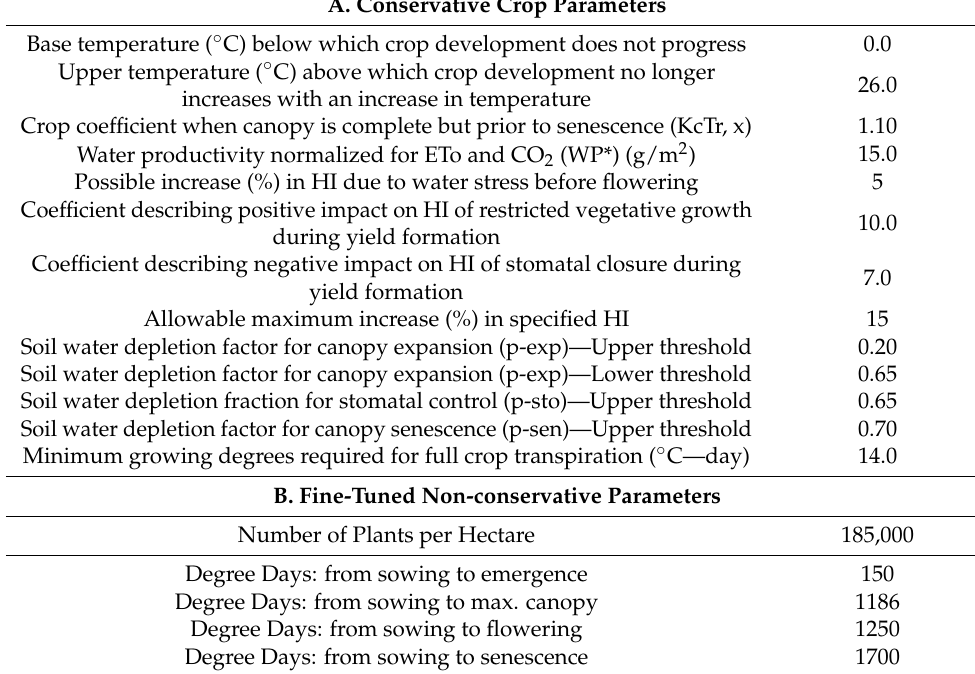
Table 2. Conservative and Fine-tuned non-conservative crop parameters used for